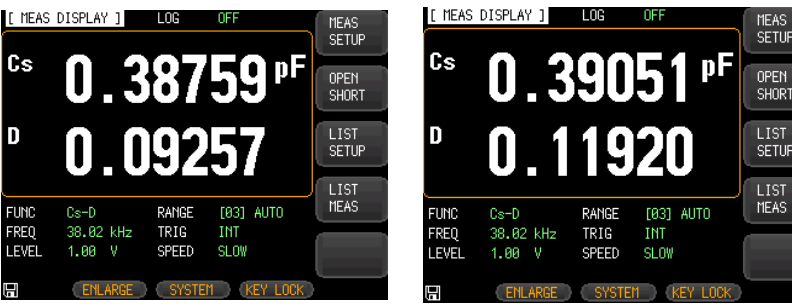
Figure 15. Interface capacitance test (sensing capacitance).